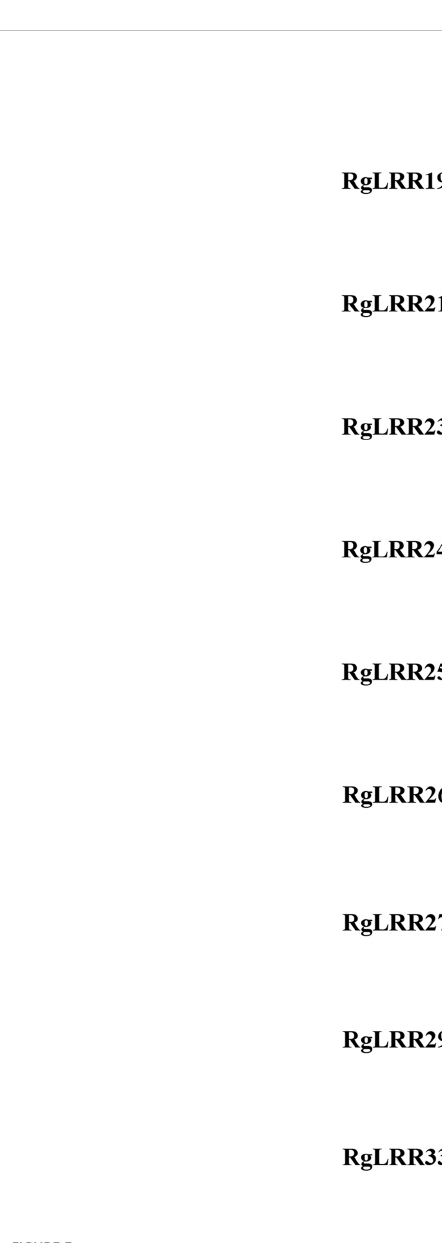
FIGURE 3 Subcellular localization of RgLRRs in Nicotiana benthamiana . GFP, Green fl uorescence protein; BF, Bright fi eld. There were fi ve replicates for each